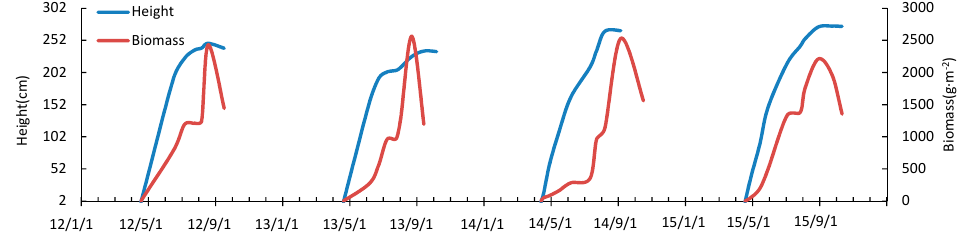
Figure 5. Plant height and biomass change.